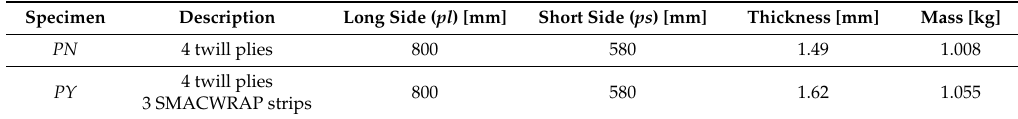
Table 1. Specimen overall